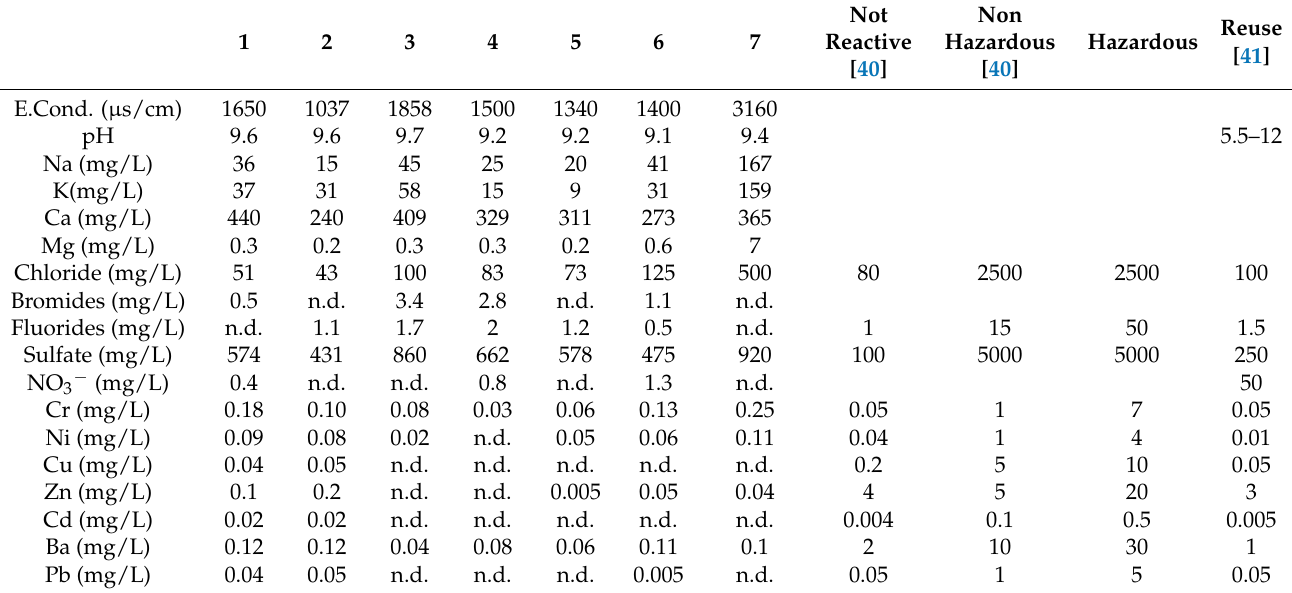
Table 2. Leaching test (L/S = 10) of the solid residue of FA after five- and twelve-step FH-WW at 80 ◦ C and five-, twelve-, and thirty-step FH-WW at 25 ◦ C. Explanation 1: N ws = 5, L/S = 5, T = 80 ◦ C; 2: N ws = 12, L/S = 5, T = 80 ◦ C; 3: N ws = 5, L/S = 5, T = 25 ◦ C; 4: N ws = 12, L/S = 5, T = 25 ◦ C; 5: N ws 30, L/S = 5, T= 25 ◦ C; 6: 24 h washing L/S = 50, T = 25 ◦ C; 24 h washing, L/S = 5, T = 25 ◦ C. Legal limits according to: